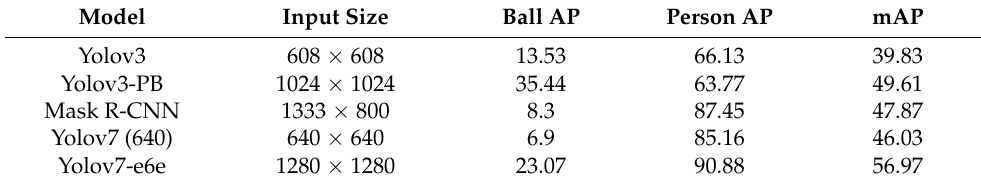
Table 1. Object detection results on UNIRI-HBD dataset.